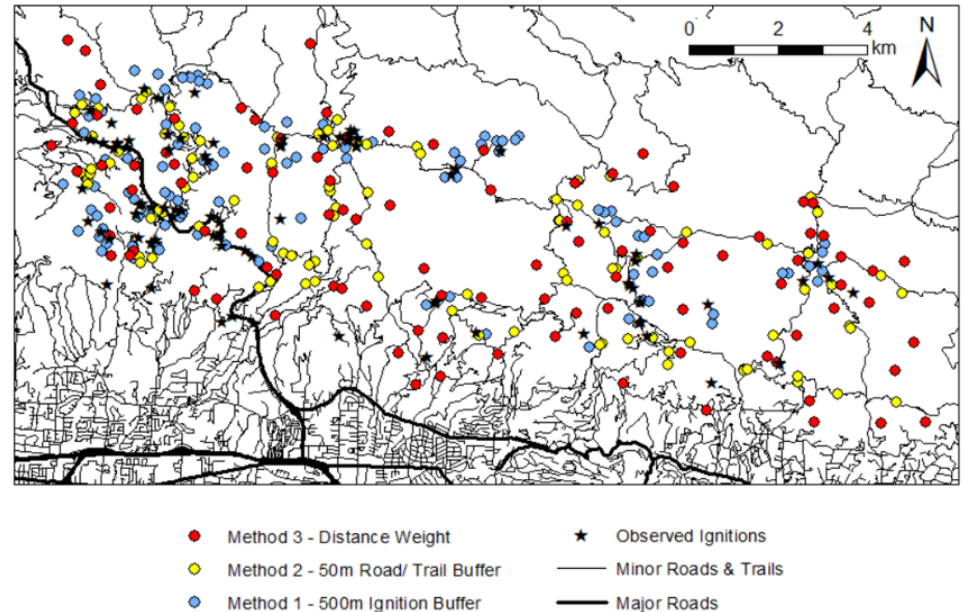
Figure A2. Fuel map for the wildfire simulations. Fuel model information can be found in [30].